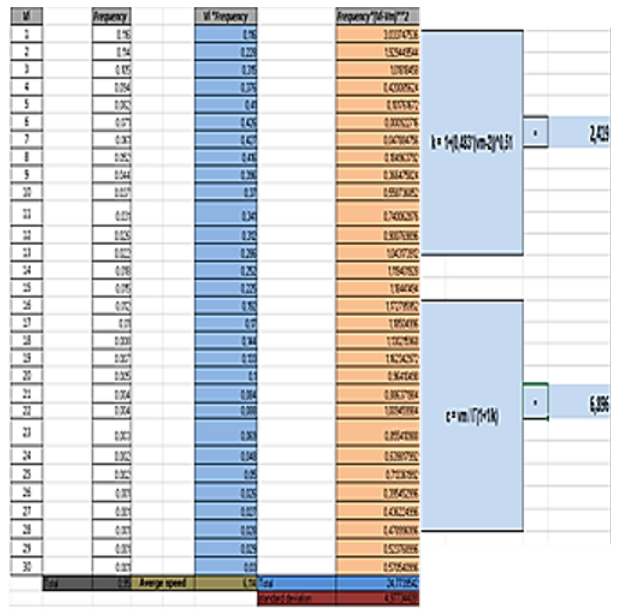
Table 4. Calculation of the Weibull parameters using the Mabchour’s method for the Laayoune.